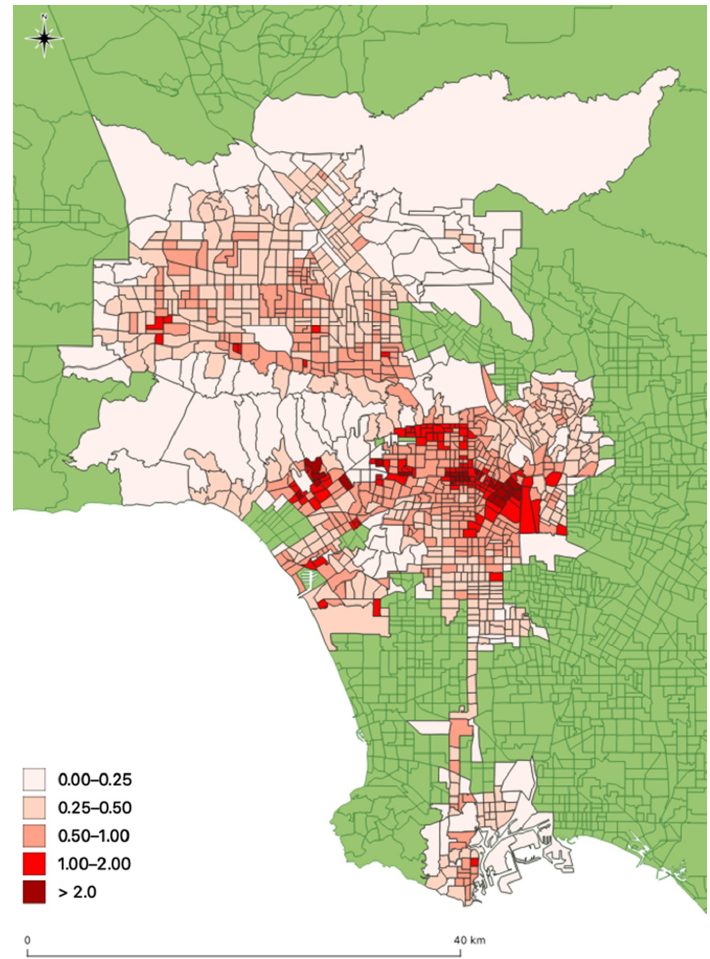
Figure 5. Census tract building density ratio in the city of LA.